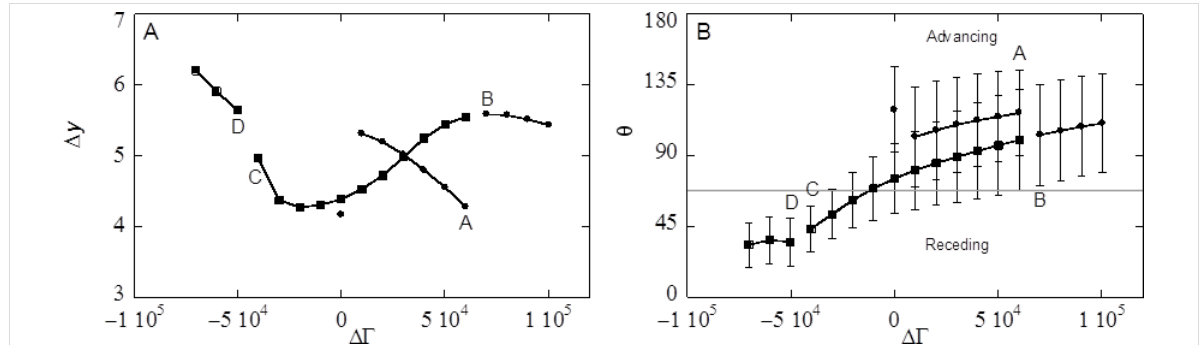
Figure 10: Examples of structural features of advancing and receding drop fronts. A) The fluctuations of the position of the liquid front along the x -direction at a height z = h + 3 as a function of the ΔΓ of the droplet component with an initial amount Γ = 3·10 6 . B) The corresponding average con- tact angle θ (measured at a height z = h + 3) and the standard deviation (plotted as error bars). The advancing liquid front is given by the solid sphere data points, the receding ones in solid square data points. The lines are to guide the eye. A discontinuity in the line represents a jump-wise change of the drops on the substrate. The labels A–D correspond to the snapshots of Figure 8 and the structural data of Figure 9. A and B are along the advancing branch, whereas C and D are taken from the receding drop fronts. Parameters are similar as in Figure 8 and Figure